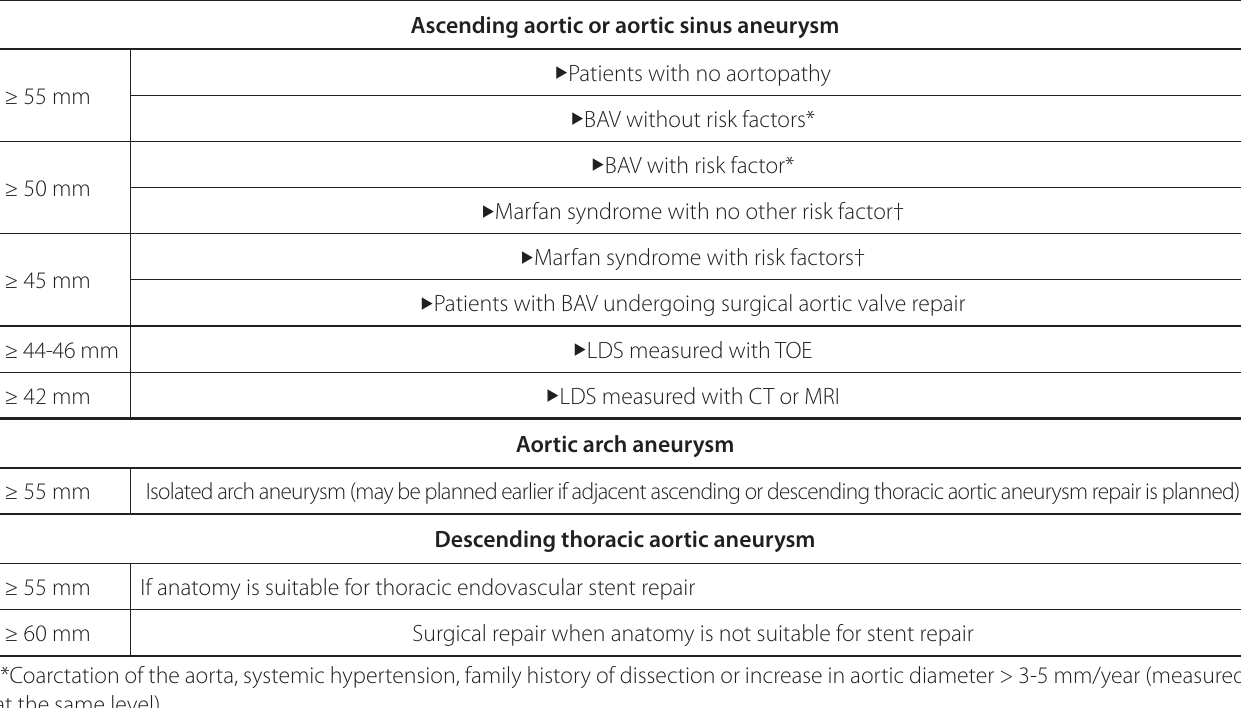
Table 7 . Class I and Class IIa recommendations on maximal aortic diameter cutoff for treatment of aortic aneurysm in asymptomatic patients [67,89]